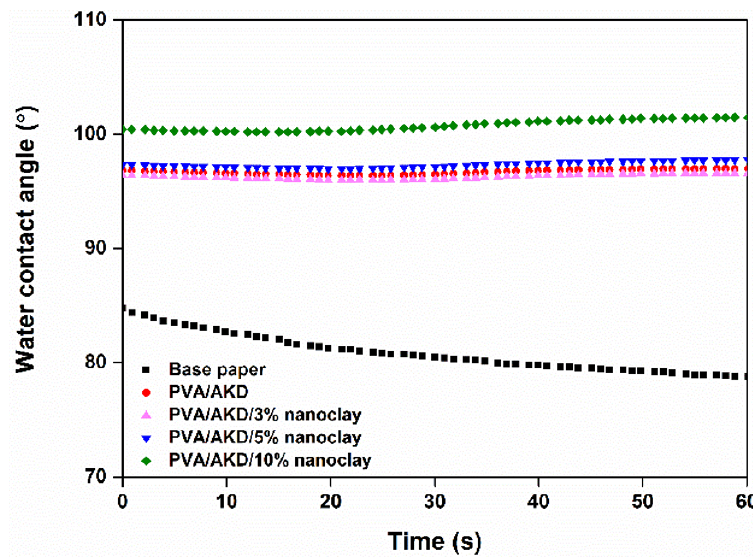
Figure 6. WCAs of the base paper and coated